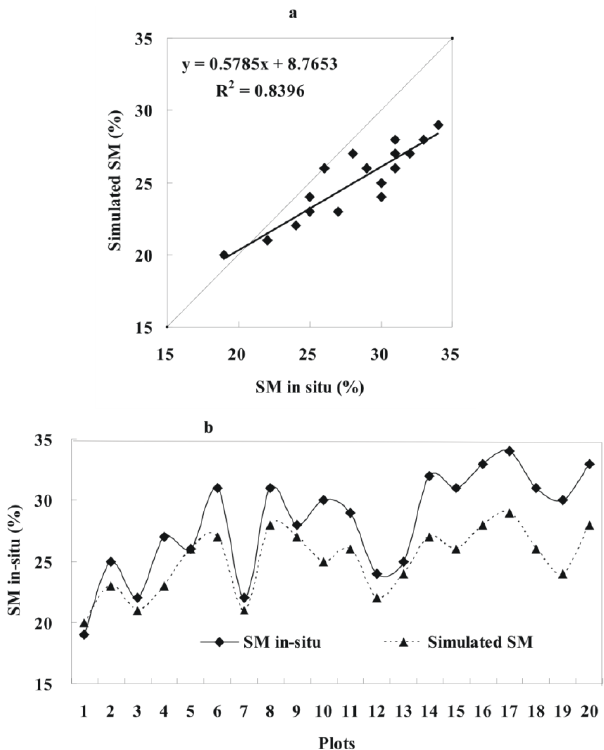
Fig. 5. Simulated soil moisture (SM) at 30m resolution using BEPS-TerrainLab in comparison with measured SM using TDR during 1 July to 31 August in 2004 (a) ; comparison of BEPS- simulated SM with measured SM at various sites (b) . The solid line is the 1 : 1 line.